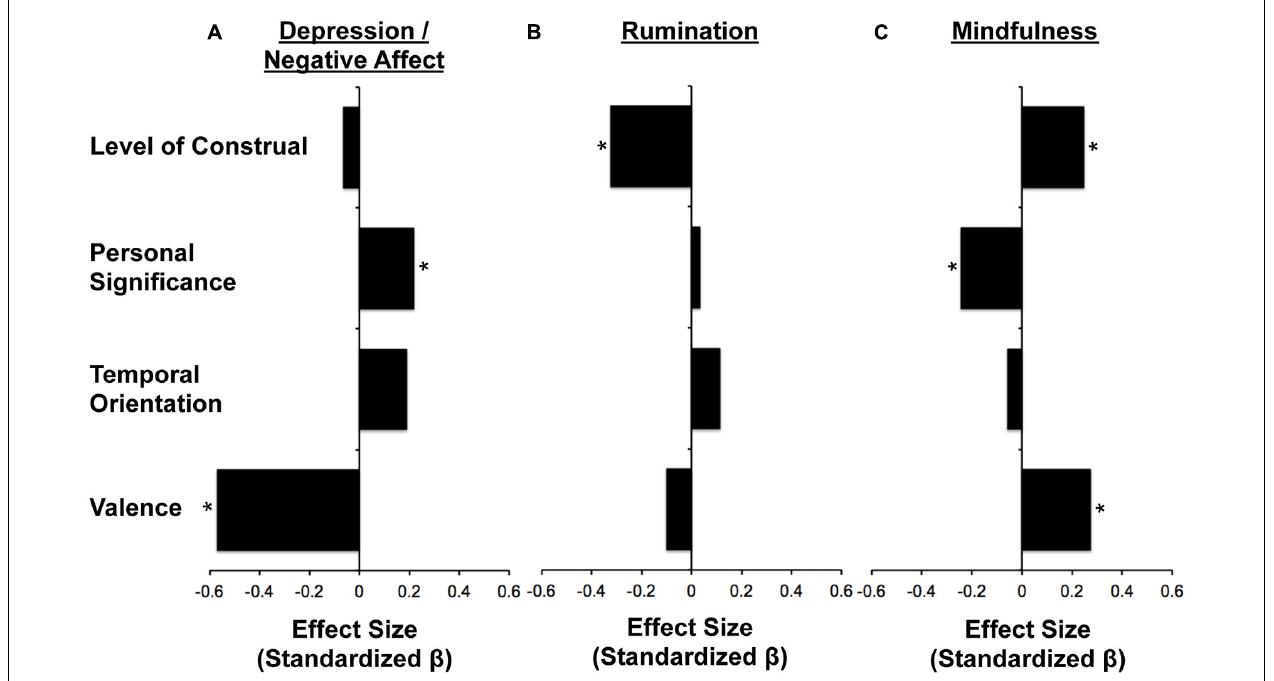
(B) Level of Construal was the only dimension that contributed a significant amount of variance toward predicting individual differences in Rumination